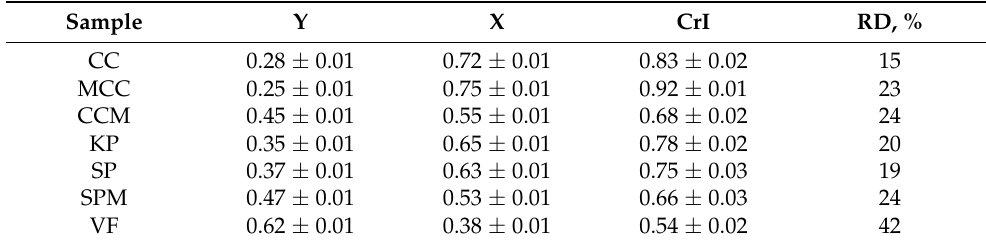
Table 3. Degree and index of crystallinity and degree of amorphicity for cellulose samples.